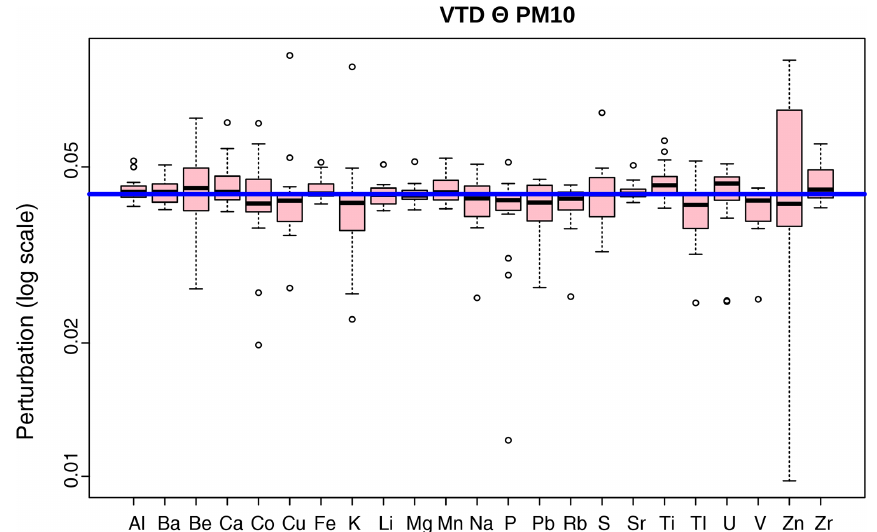
Figure 8. Perturbation diagram as box plots for paired samples (all elements except REEs), measured by PM10 and the VTD. The horizontal blue line represents no